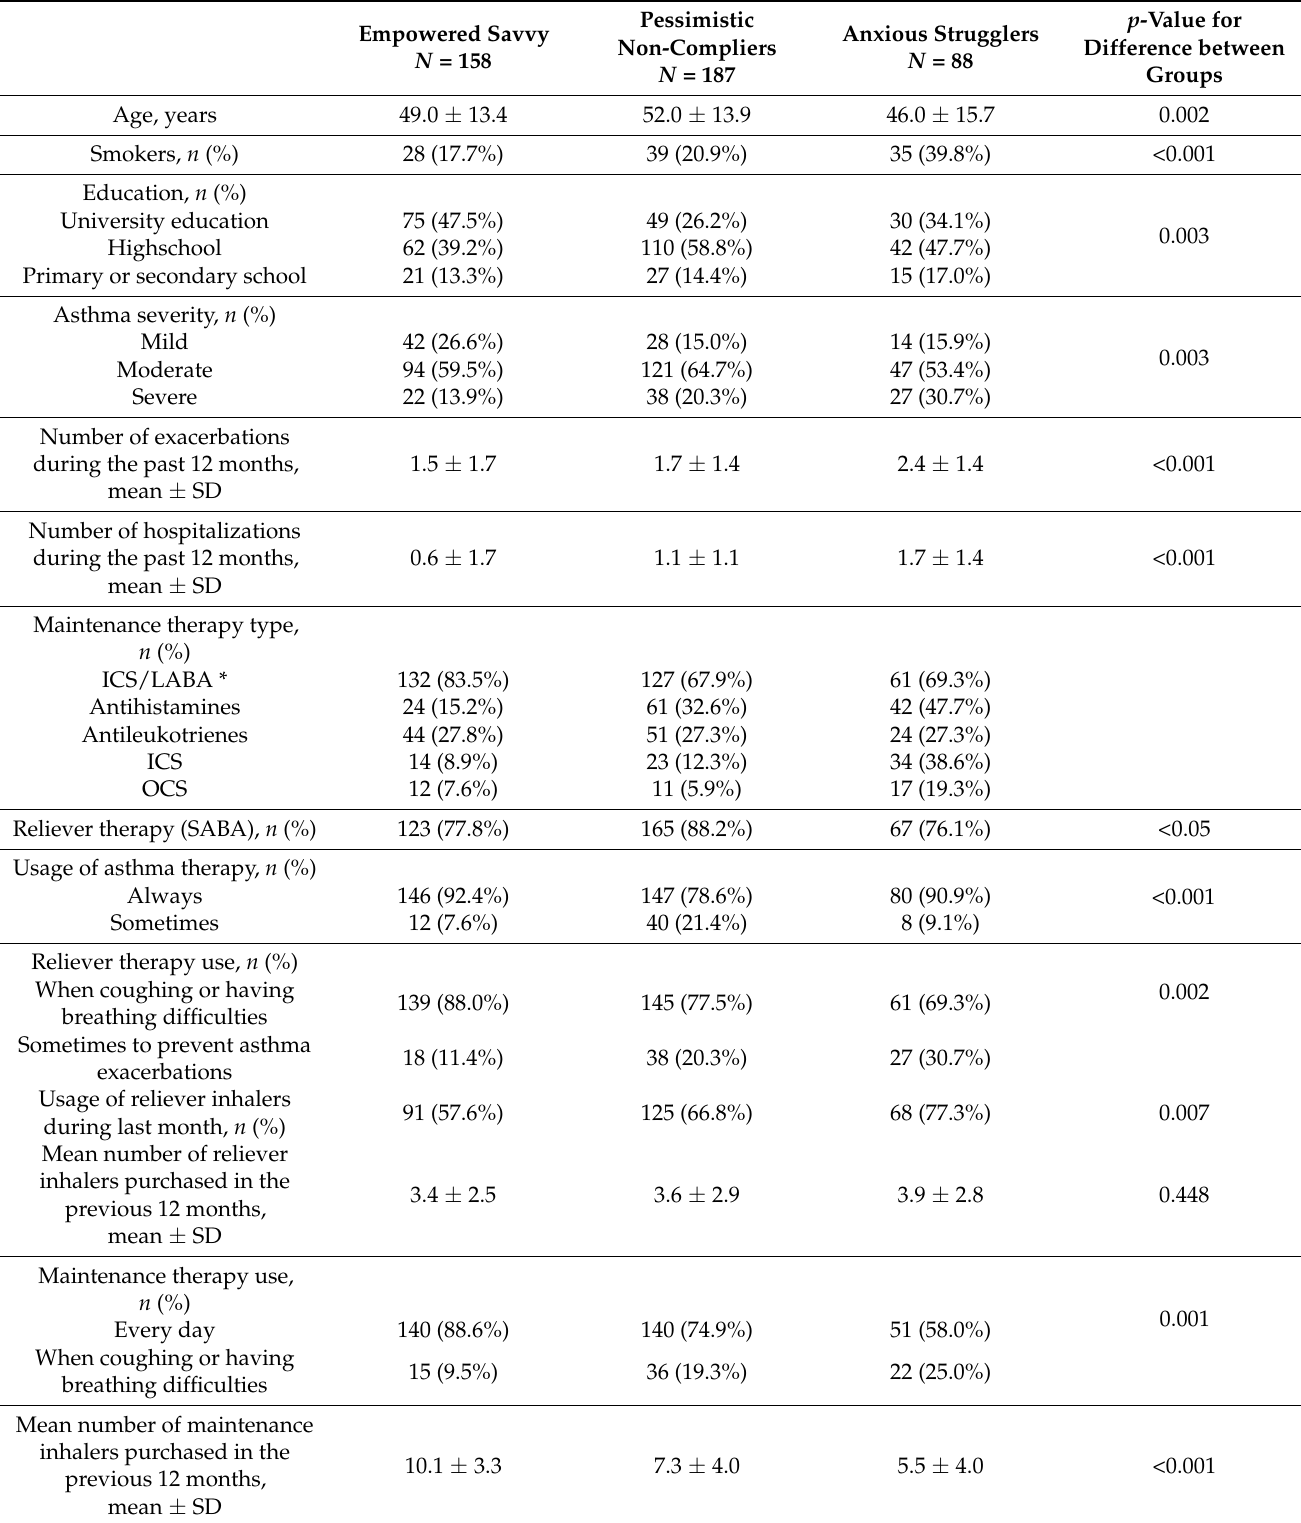
Table 4. Patient characteristics for each attitude cluster